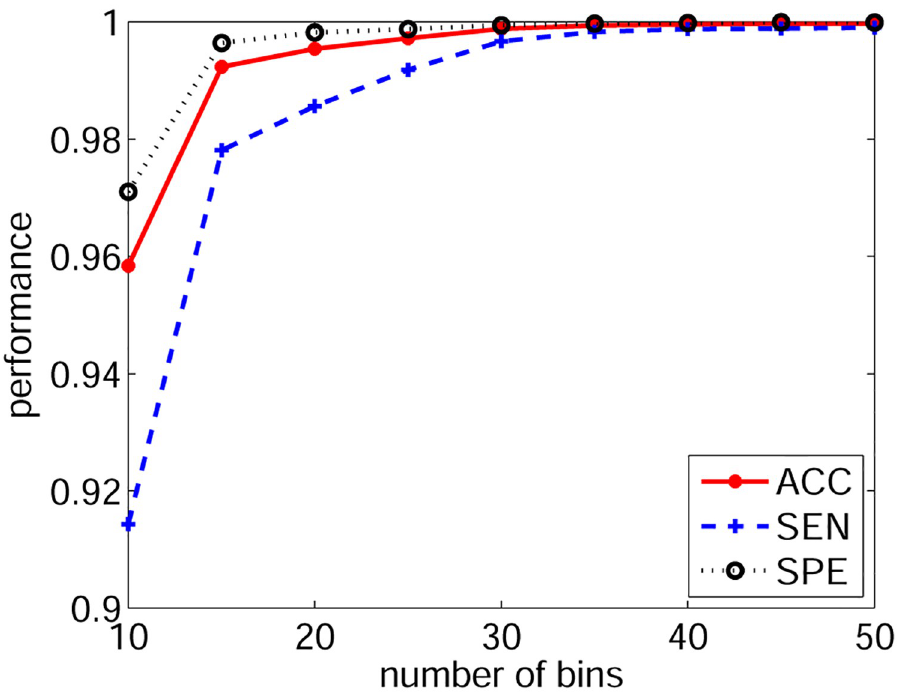
Fig 4. The performance with different histogram bin